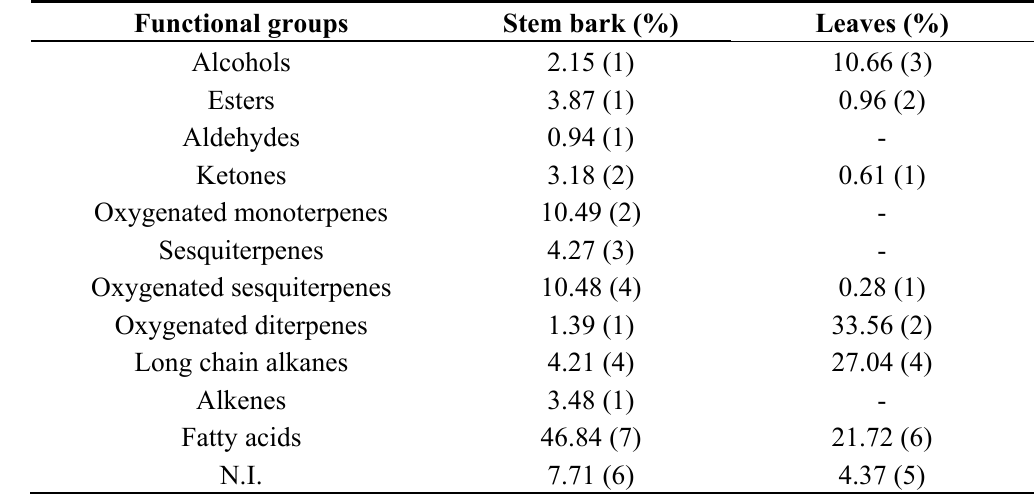
Table 4. Chemical class distribution of the oil components from the stem bark and leaves of I. laurina in the rainy